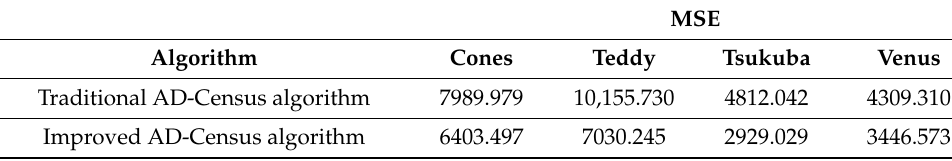
Figure 5. Comparison of algorithm results: ( a ) the original diagram corresponding to the four groups of images of Cones, Teddy, Tsukuba, and Venus, respectively, ( b ) the disparity map corresponding to the traditional AD-Census algorithm, corresponding to the four groups of images, and ( c ) the disparity map of the improved AD-Census algorithm corresponding to the four groups of images. Table 2. Comparison of algorithms’ MSE.